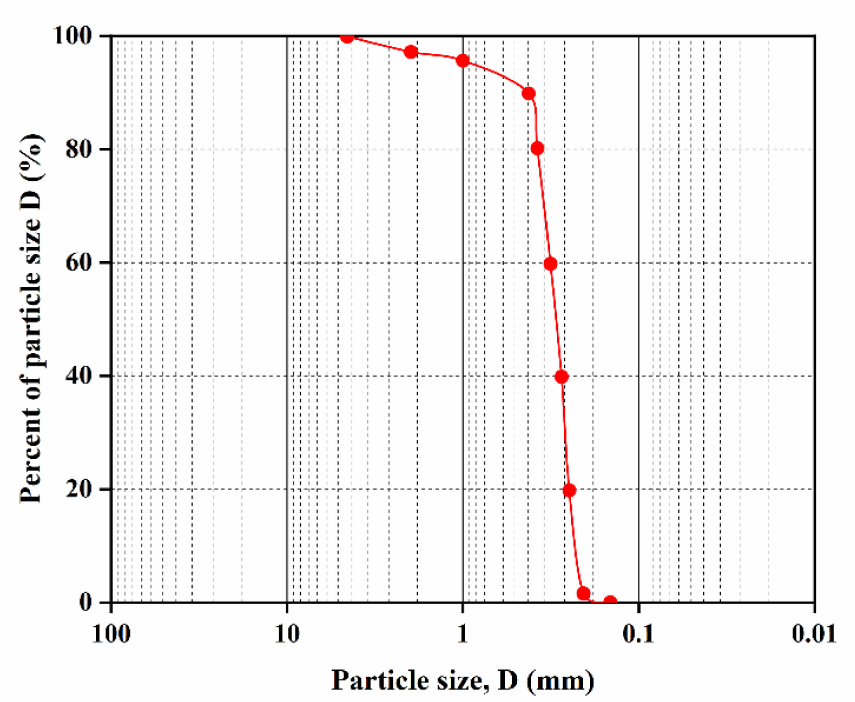
Figure 4. Grain size distribution of the sand (this distribution was only used to calibrate parameters and not for subsequent seepage